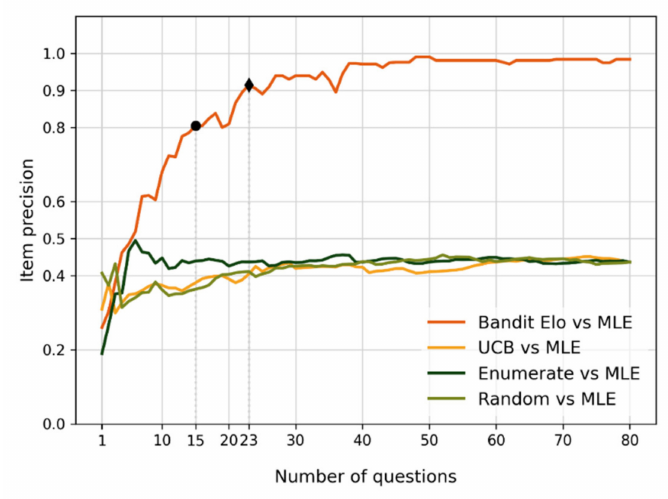
Figure 7. Mean algorithm precision estimating personalized suitable items as measured against IRT MLE.